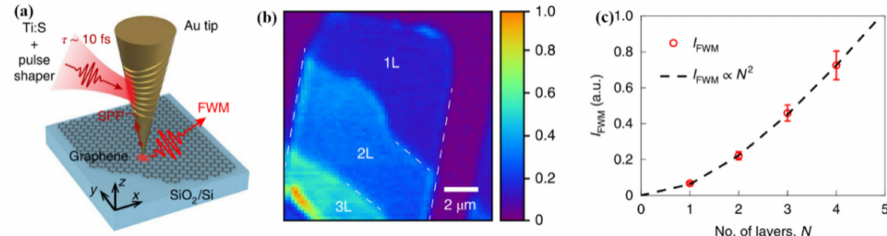
Figure 7. ( a ) Schematic illustration of the Au tip after grating etching for localized FWM excitation. ( b ) Near-field FWM imaging of monolayer and bi- and tri-layer graphene. The white dotted line is the edge of the graphene. ( c ) Fitted model of the dependence of thickness ( n ) on the intensity of integrated FWM ( I FWM ) [47]. Republished with permission from Ref. [47]. Copyright 2022 Springer